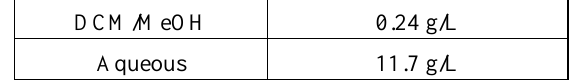
Table 6. Overall Average Weight of Extract (based on ~13,000 most frequently utilized